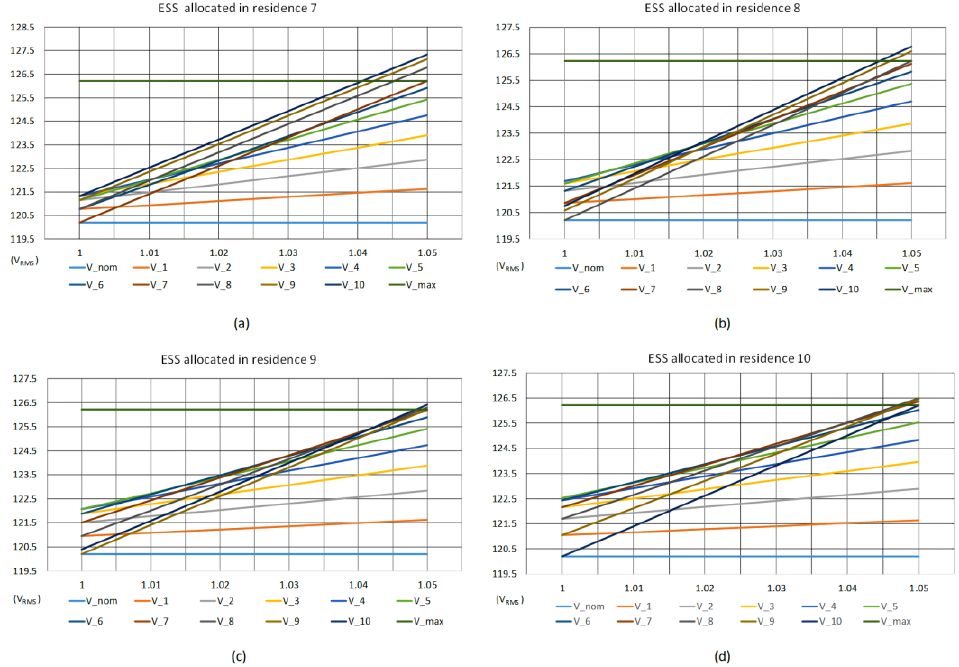
Figure 5. Node voltages (V RMS ) under different regulating voltage levels. ( a ) ESS allocated in residence 7, ( b ) ESS allocated in residence 8, ( c ) ESS allocated in residence 9, and ( d ) ESS allocated in residence 10.